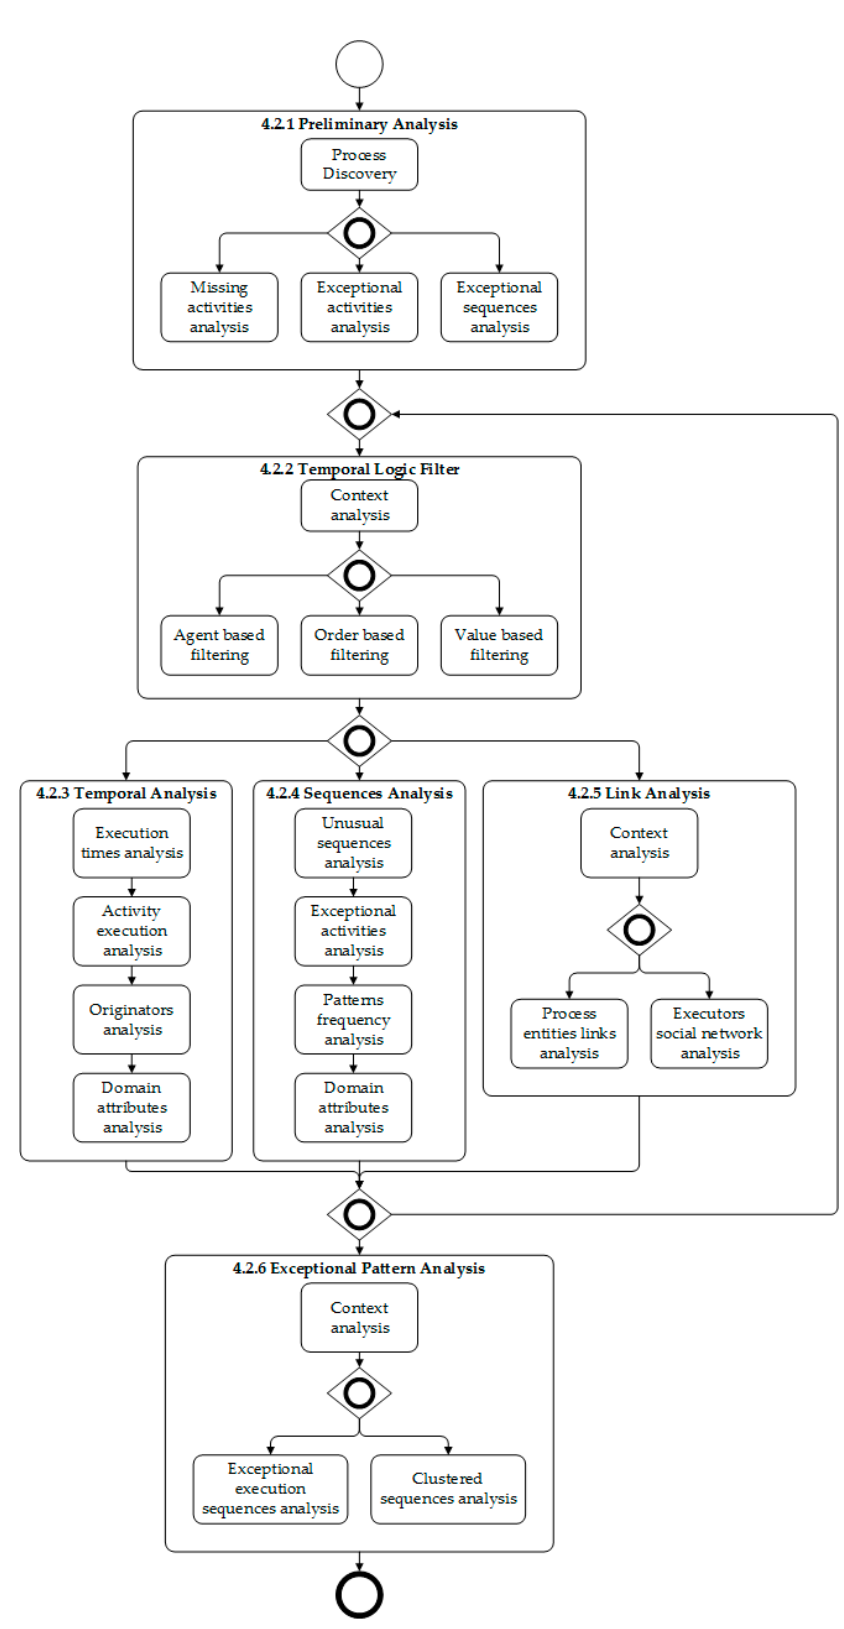
Figure A1. Visual analysis process.